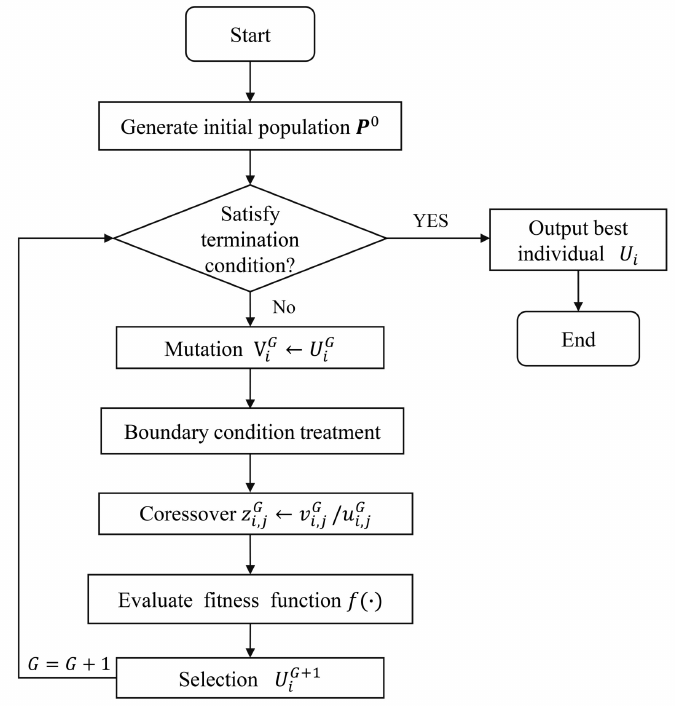
Figure 3. The flow chart of DEO